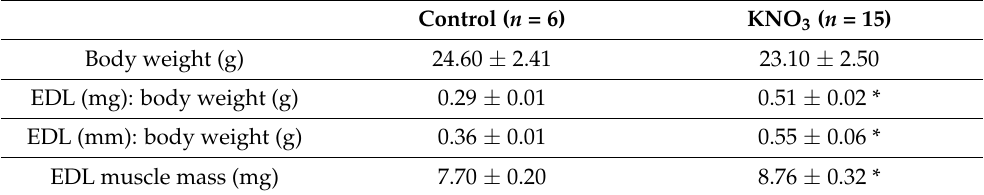
Table 1. Body weight and EDL muscle: body weight ratio in control and KNO 3 -fed mice.